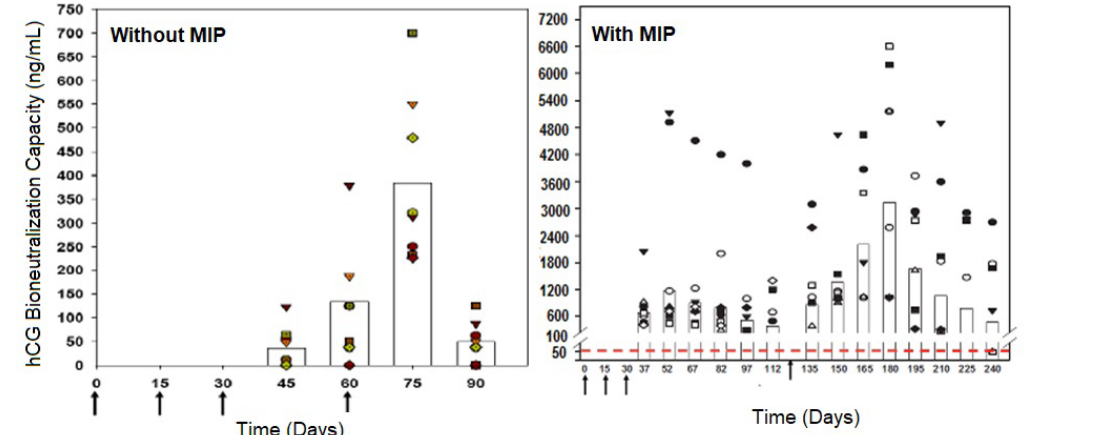
Figure 4 . Enhancement of antibody response to the hCGβ-LTB vaccine in Balb/c mice by MIP . Mice were immunized intra-muscularly with 2μg of the vaccine adsorbed on alum with or without MIP . Primary immunization consisted of 3 injections given at fortnightly intervals followed by a booster on day 60 or 120. The symbols represent the titers in a given mouse. Bars give the geometrical means Note . Reprinted from “Making of vaccines against human chorionic gonadotrophin for control of fertility of women without impairment of ovulation and menstrual regularity” by Talwar GP, Gupta JC, Nand KN, Thapa R, Mehta M. Reproductiv Immunol Open Acc. 2016;1:4 (https://doi.org/10.21767/2476-1974.100004). CC